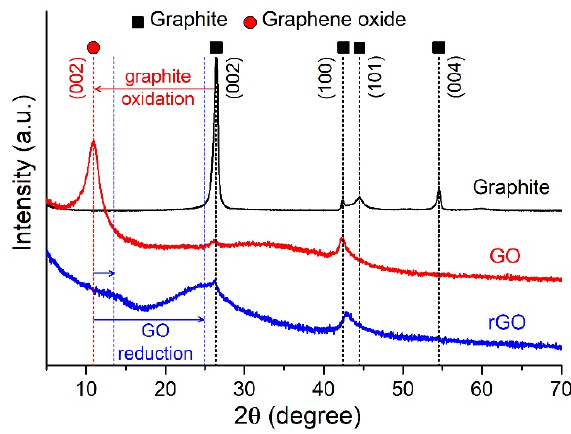
Figure 1. XRD patterns of graphite, GO, and rGO samples.